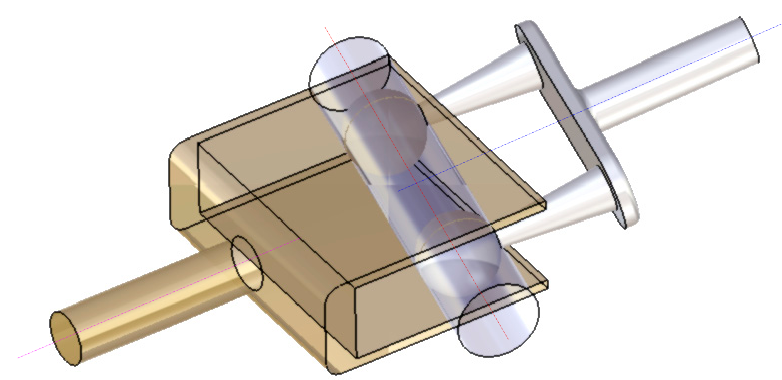
Figure 7. Technical constructive solutions for bipod joint.